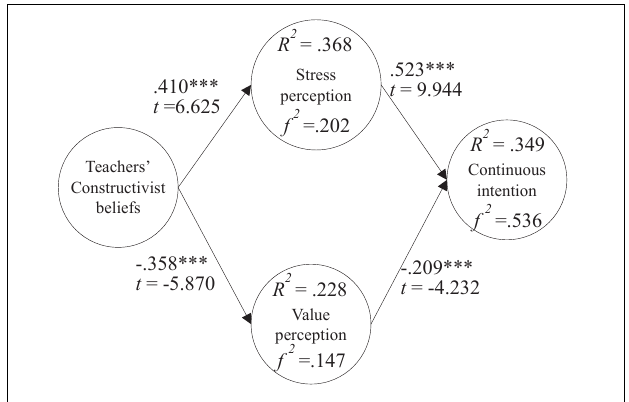
FIGURE 2 | Validation of the research model. ∗∗∗ p < 0.001.